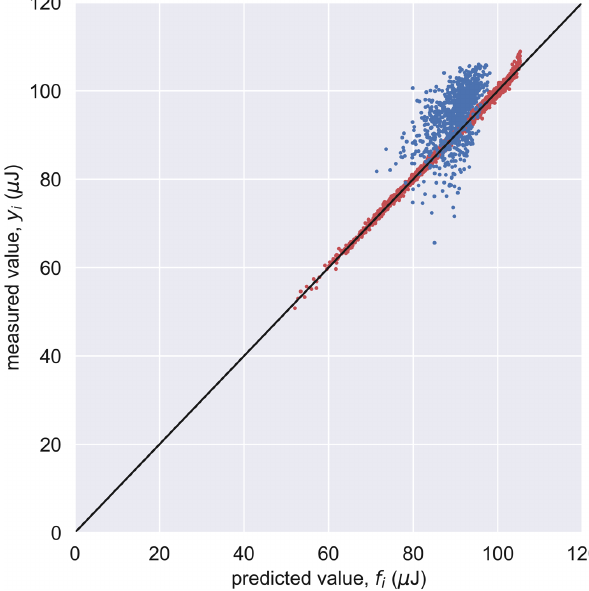
FIG. 2. Comparison of two of the data points shown in Fig. 1. The red dots compare the predicted and measured values for the training set ( R 2 ¼ 0 . 995 ) while the blue dots show the same for the point at approximately 16 minutes ( R 2 ¼ − 0 . 054 ). The black line shows a model with perfect prediction